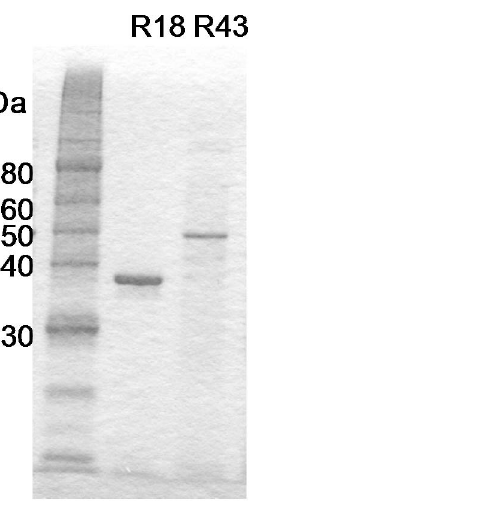
Figure 2. SDS-PAGE analysis of R18 and R43. Lane 1: protein standard; Lane 2: R18; Lane 3: R43. Powdered enzyme (100 m g) was dissolved in distilled water and loaded onto each lane.